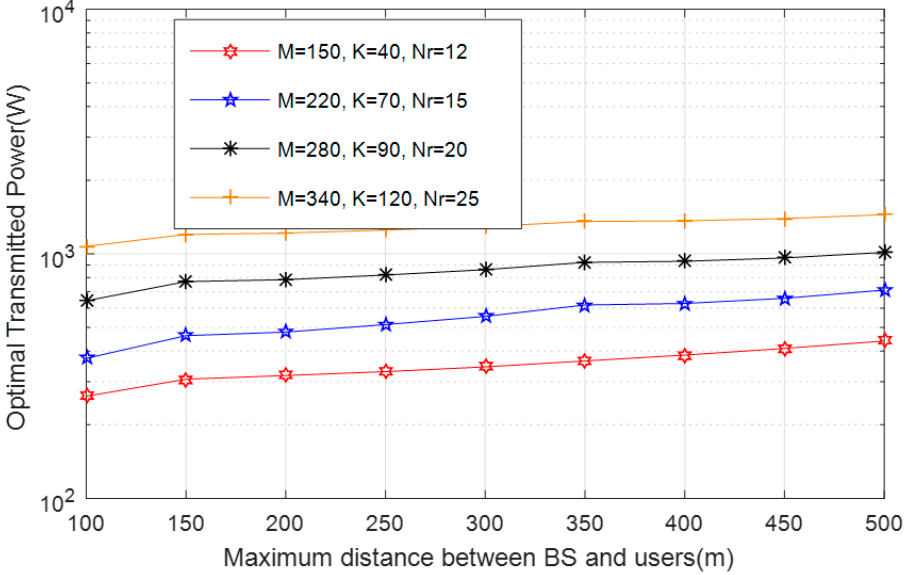
Figure 6. Optimal transmitted power.